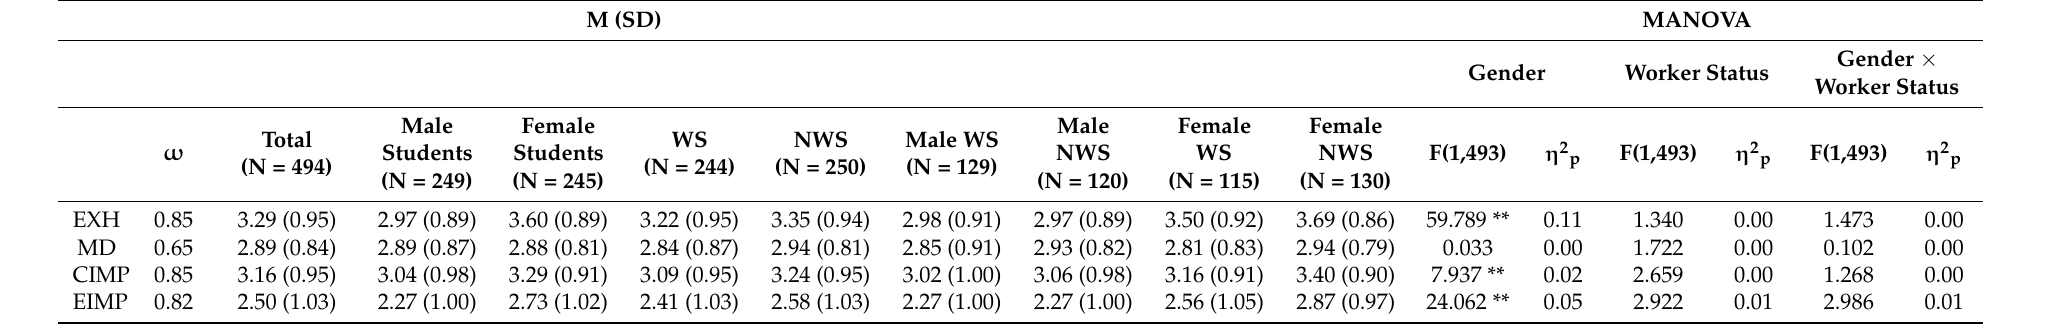
Table 4. Means, standard deviations, and MANOVA results for gender and worker status. M (SD) MANOVA